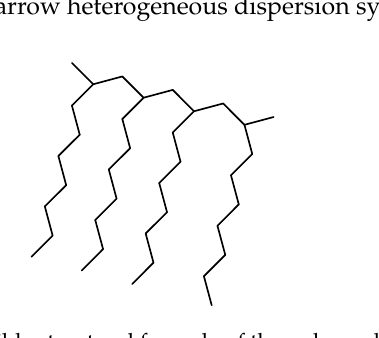
Figure 2. Molecular weight distributions of S rt , S 180 , S 200 , S 230 , S 250 , S 270 , and S 300 .